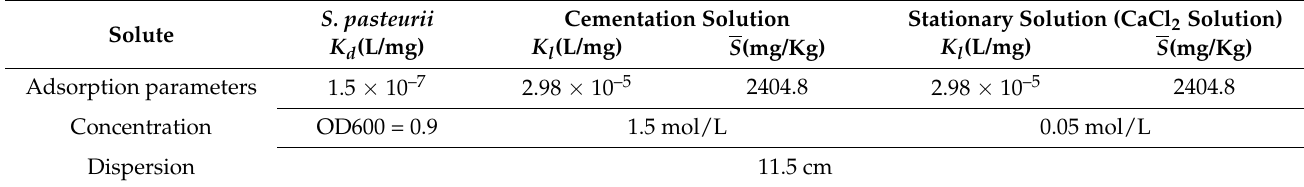
Table 4. Solute transport